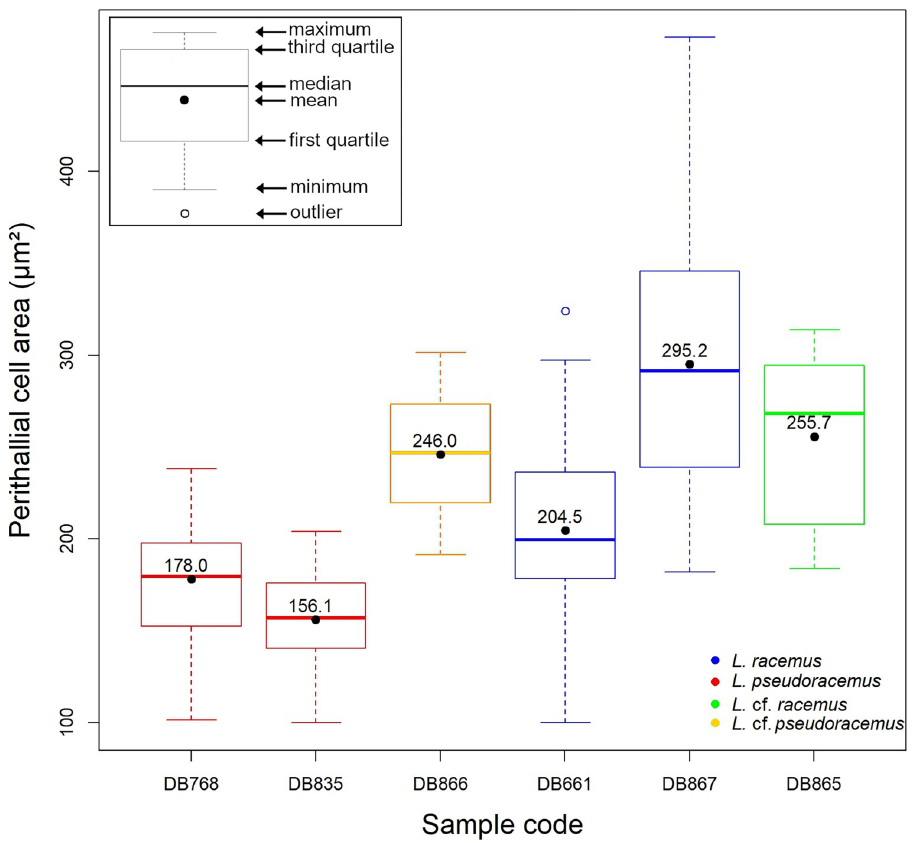
Fig 7. Box plot with the results of the perithallial cell area measurement. The numbers inside the plots indicate the mean values.